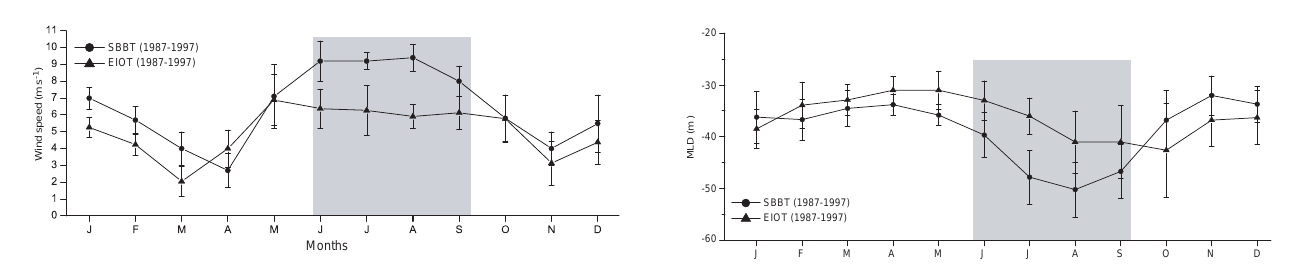
Fig. 8. Monthly mean climatology (1987–1997) of mixed layer depth (MLD), at SBBT (filled circle) and EIOT (filled triangle). Shading represents the summer monsoon period (June–September) and vertical lines are one standard